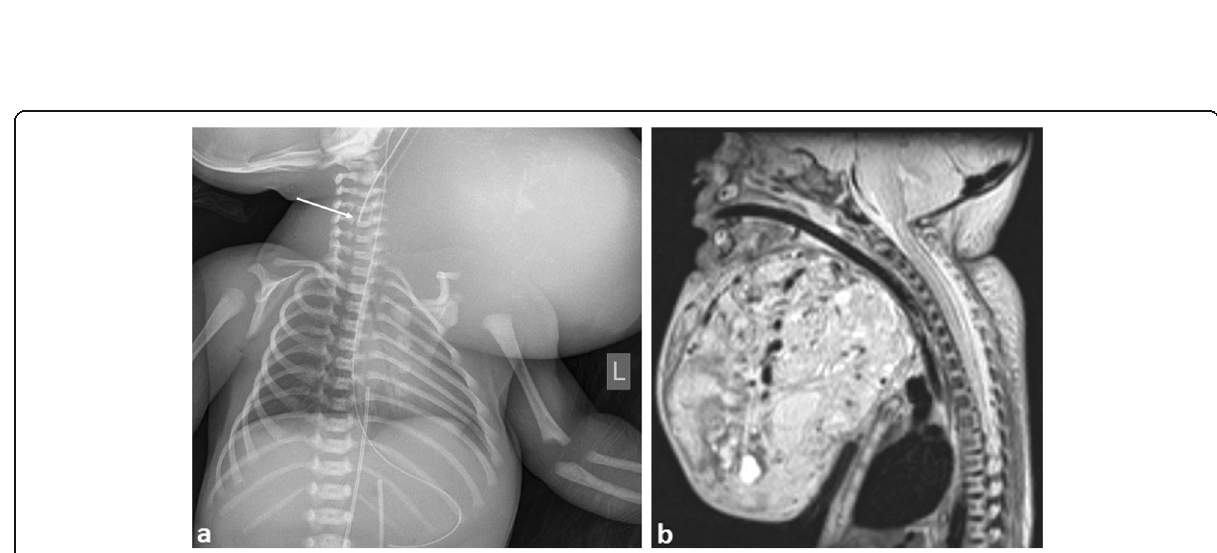
Fig. 9 A neonate antenatally diagnosed with a large cervical teratoma. The patient was delivered at 34 weeks gestation by ex utero intrapartum treatment (EXIT) procedure due to impending airway obstruction. a Initial chest radiograph of patient post intubation. Note the high position of the endotracheal tube tip from difficult intubation (arrow). This should lie at the T2 vertebral level. b Sagittal postnatal T2-weighted MRI image demonstrating the large cervical mass and proximity to the upper airway. The patient had been successfully intubated during the MRI study, thus accounting for the patency of upper airway diameter in this